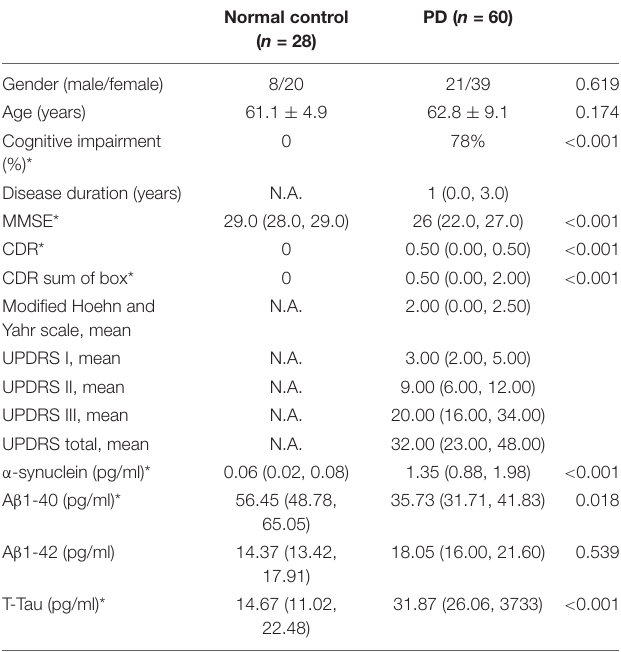
TABLE 1 | Clinical characteristics in Parkinson’s disease